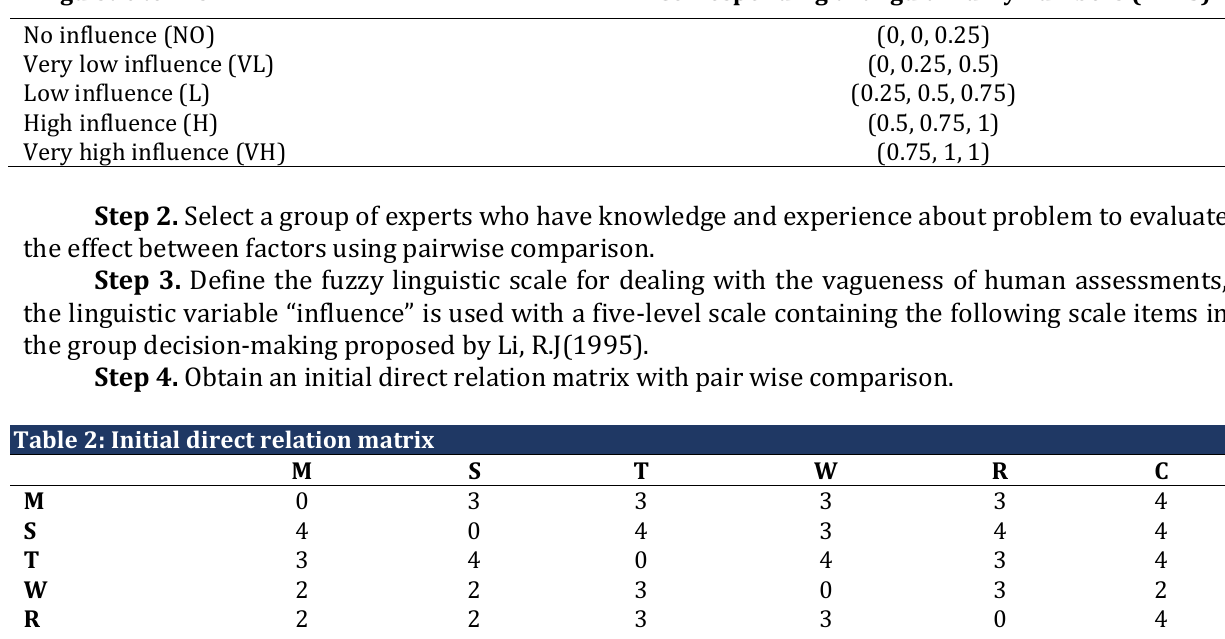
Table 1: Linguistic terms and TFN numbers Linguistic terms